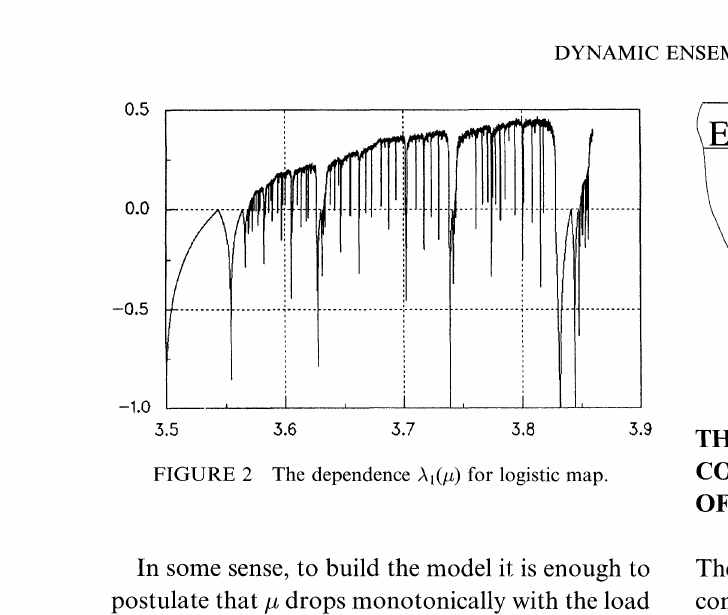
FIGURE 3 Scheme of near-surface